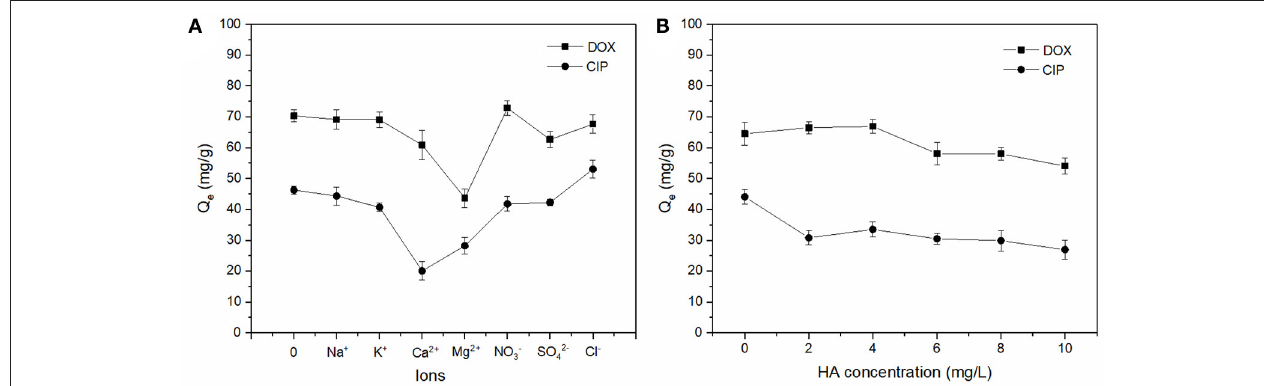
FIGURE 3 | Effect of background electrolyte (A) and HA (B) on the adsorption of DOX and CIP by BC700 (initial concentration = 40 mg/L; ions concentration = 0.04 mol/L; sorbent dose = 0.4 g/L; temperature = 298K; contact time = 24h; pH =